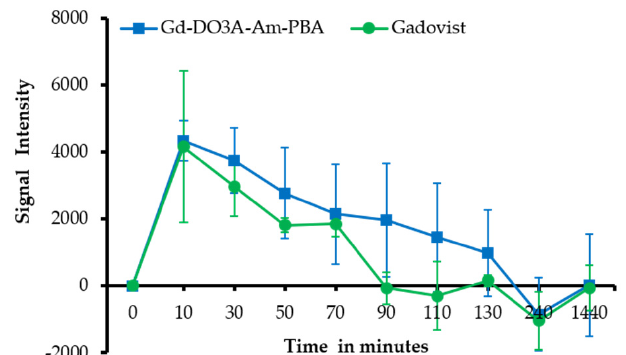
Figure 9. Quantification of kidney SNR after the intravenous injection of Gd-DO3A-Am-PBA and Gadovist. Error bar represent mean ± standard error values from three independent experiments. SNR: signal-to-noise-ratio.